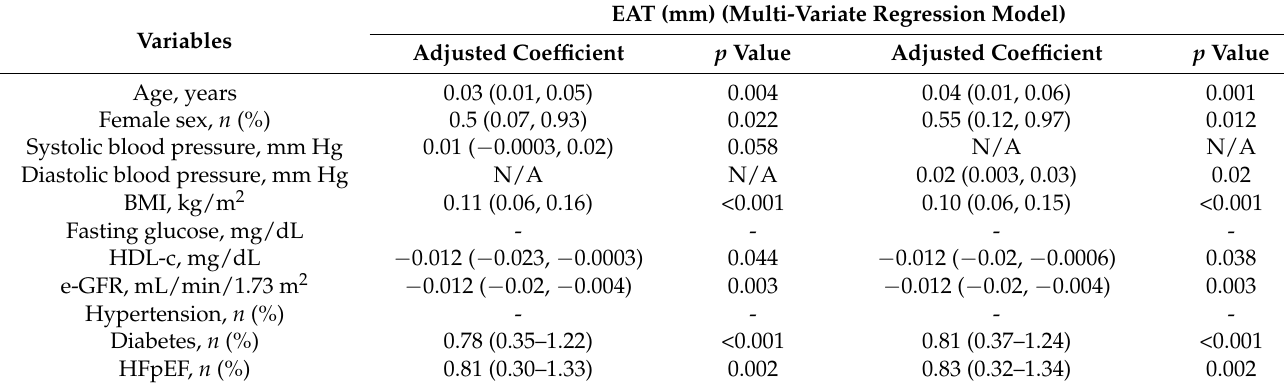
Table 2. Association of EAT (as outcome measure) with baseline demographics on Pearson Correlation Test and Linear Regression